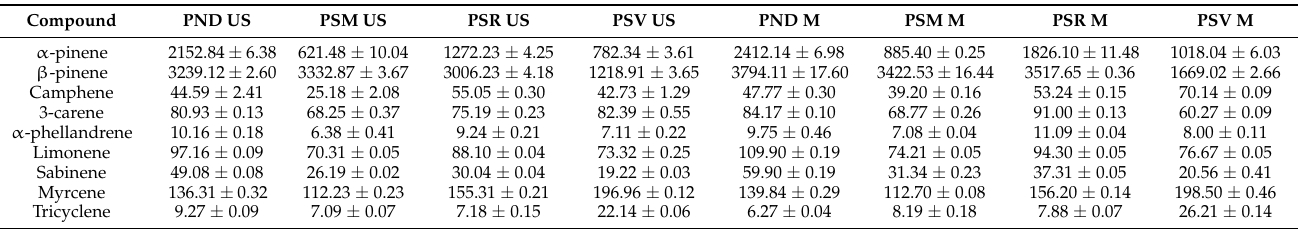
Table 1. Qualitative and quantitative results of the pine bark extract volatile compounds analysis ± st. dev. ( µ g/g bark). Compound